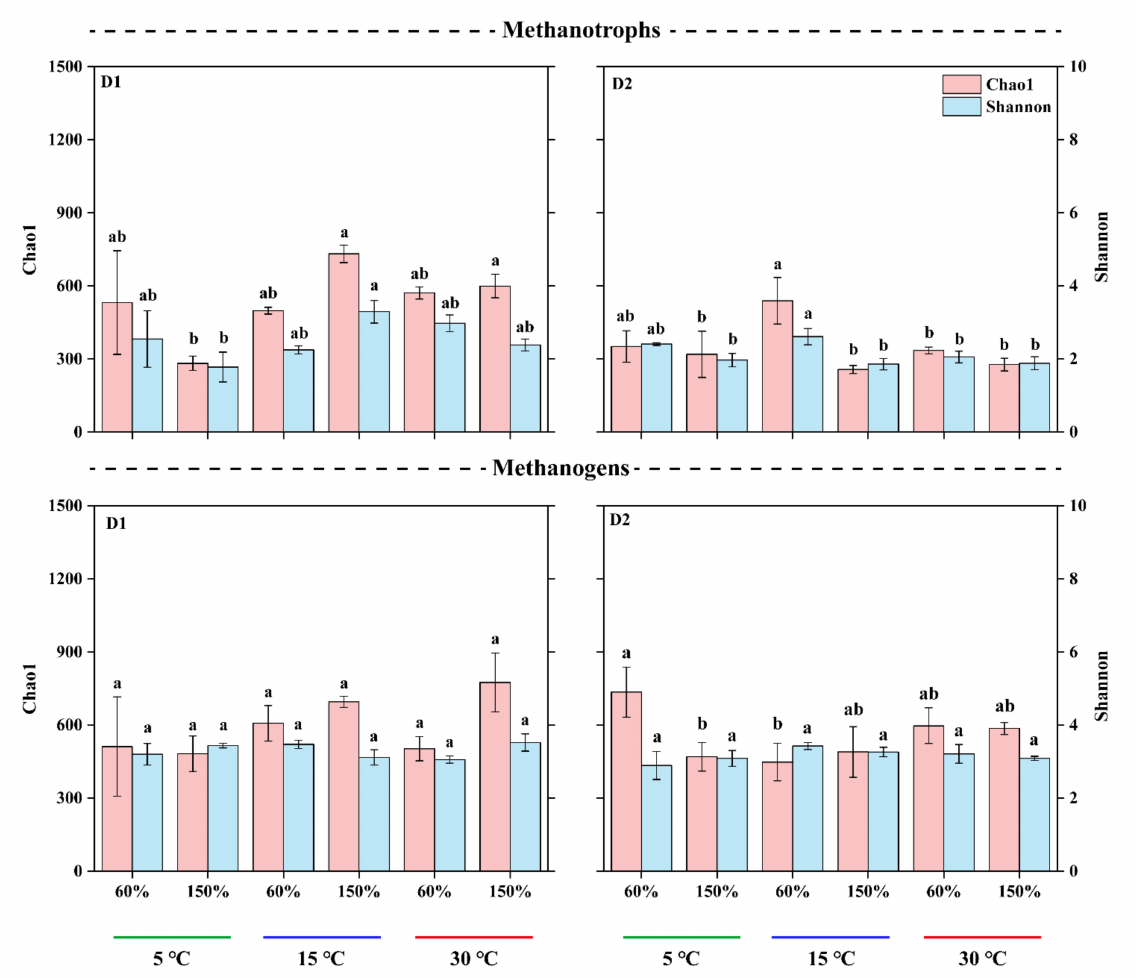
Figure 4. Community abundance (Chao1) and diversity (Shannon) of methanotrophs (upper figures) and methanogens (lower figures) in soil samples after incubation at temperatures of 5, 15, and 30 ◦ C in combination with soil moisture states of 60% and 150% water-filled pore space. Samples from two soil depths were incubated: D1 (0–20 cm) and D2 (20–50 cm). Different lowercase letters indicate significant differences between treatments ( p <